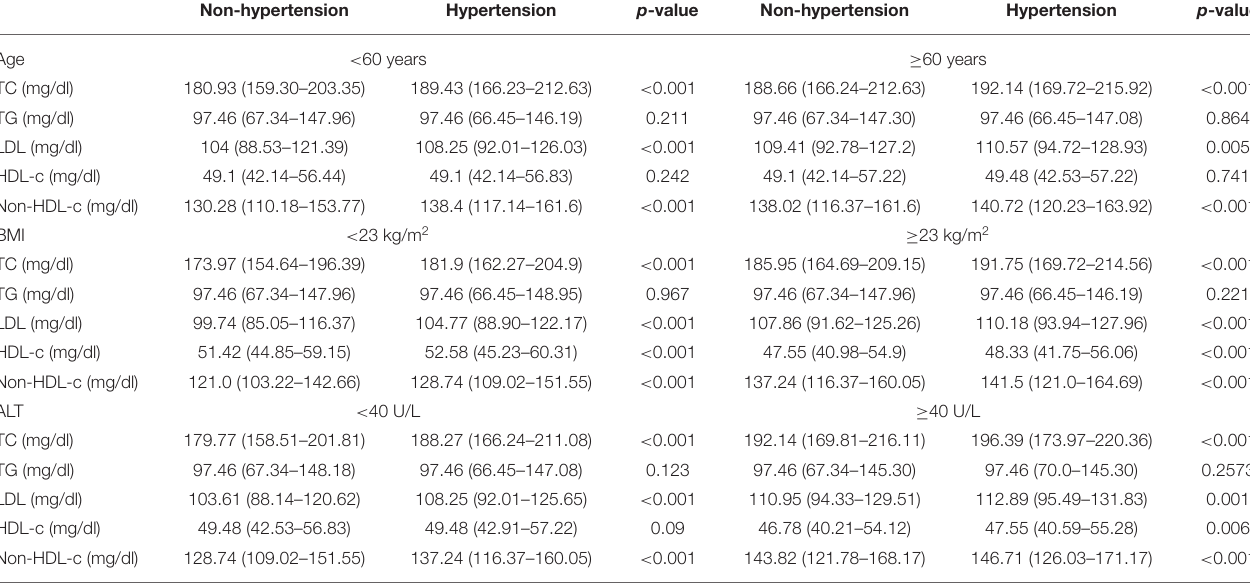
TABLE 2 | Subgroup analysis of lipid profiles differences between non-hypertension and hypertension according to age, BMI, and ALT *